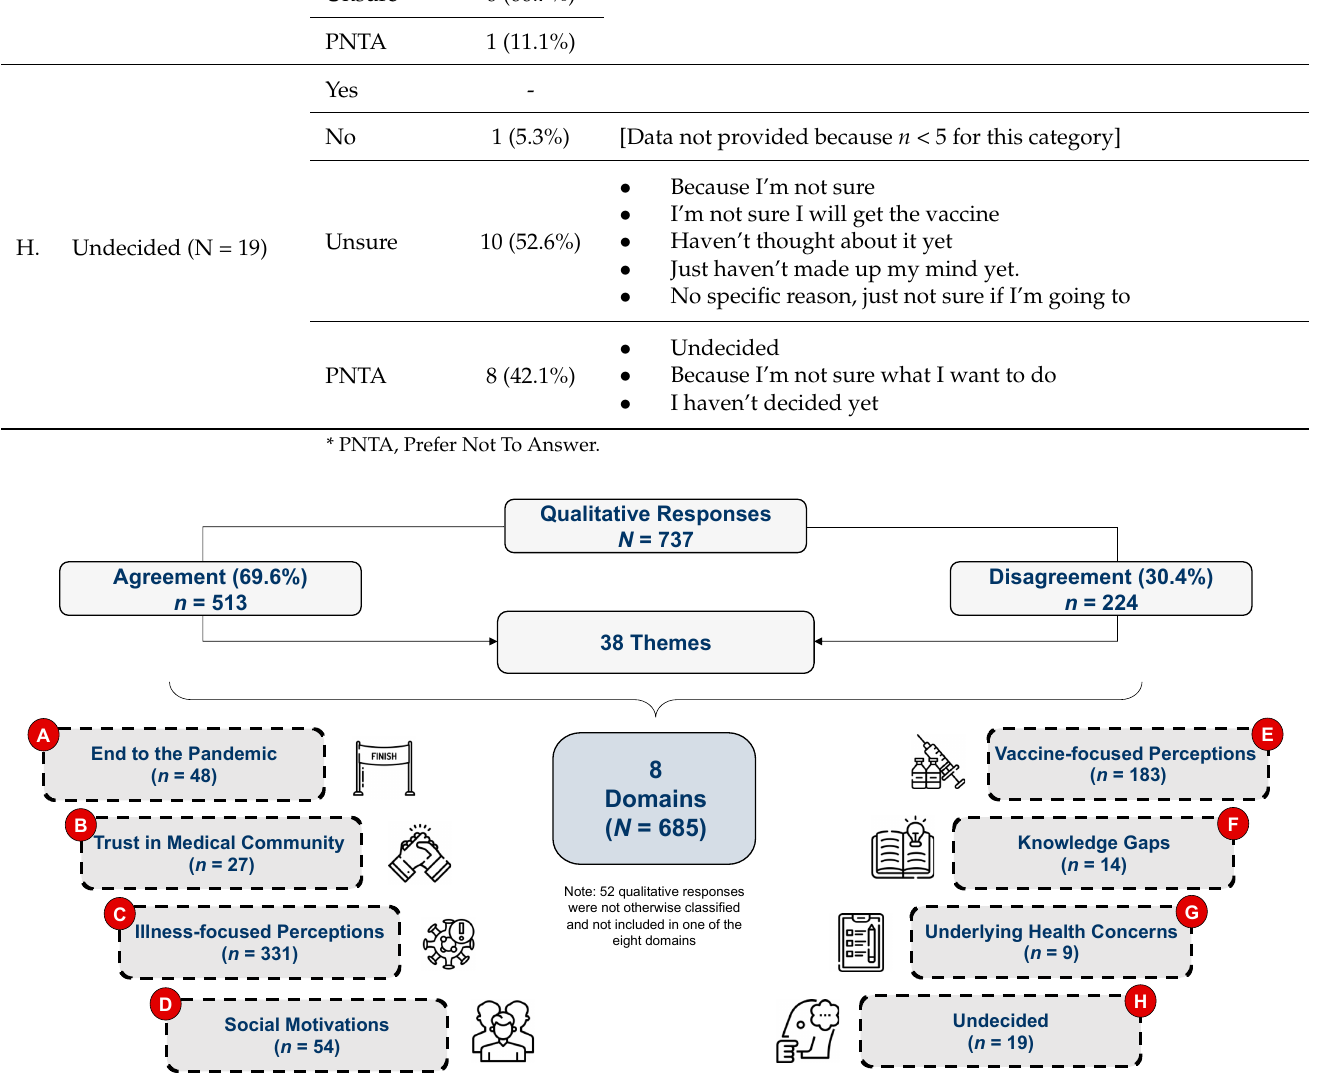
Figure 1. The inductive analytic process to stratify 685 responses into eight domains.